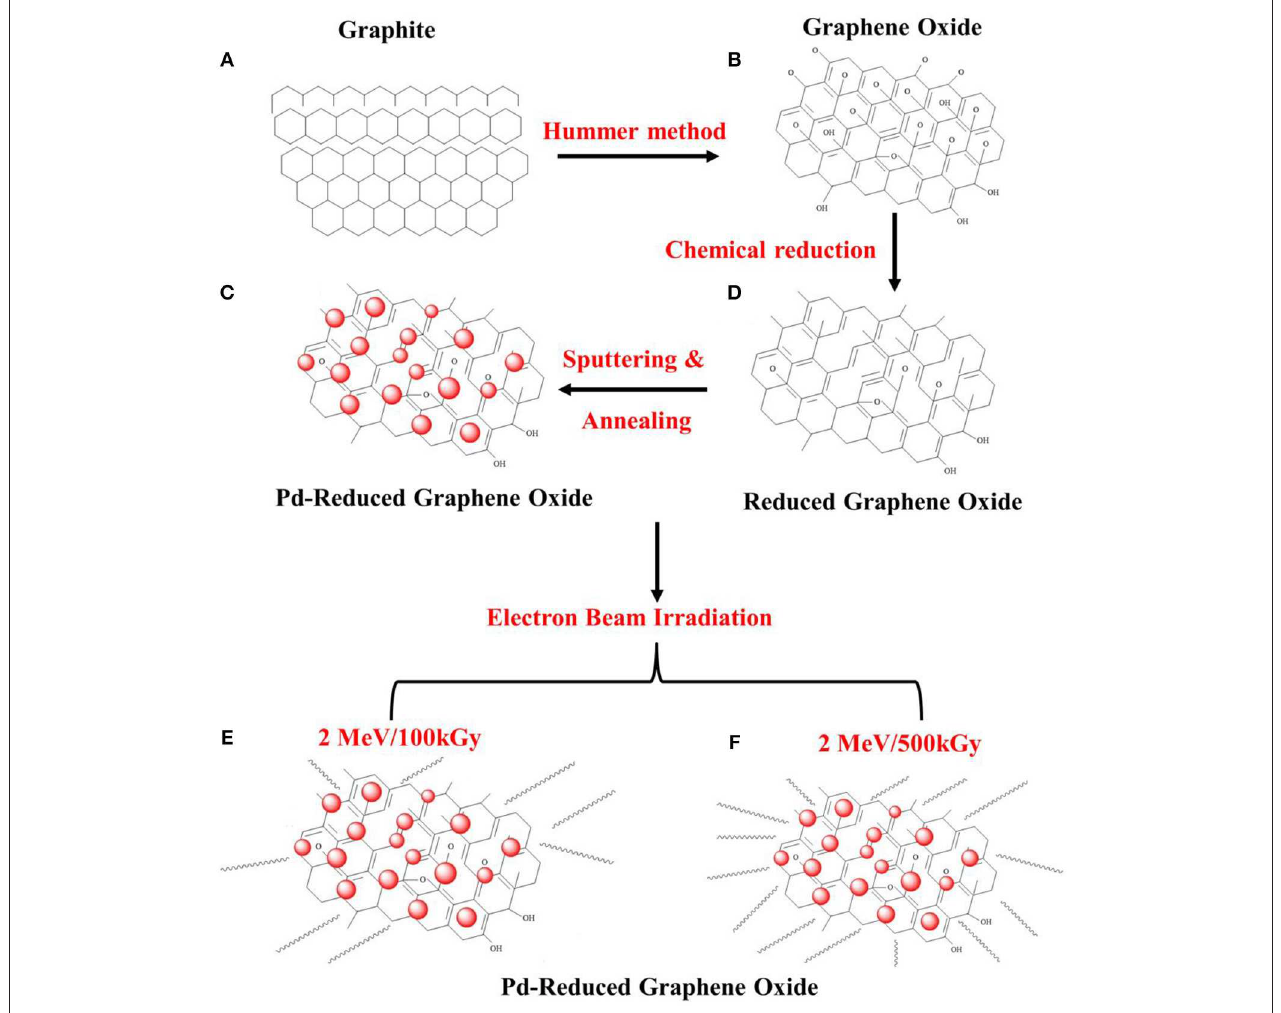
FIGURE 1 | Schematic illustration for the synthesis procedure in this study: (A) graphite, (B) graphene oxide, (C) RGO, (D) Pd-functionalized RGO, (E) 2 MeV/100 kGy irradiated Pd-functionalized RGO, and (F) 2 MeV/500 kGy irradiated Pd-functionalized